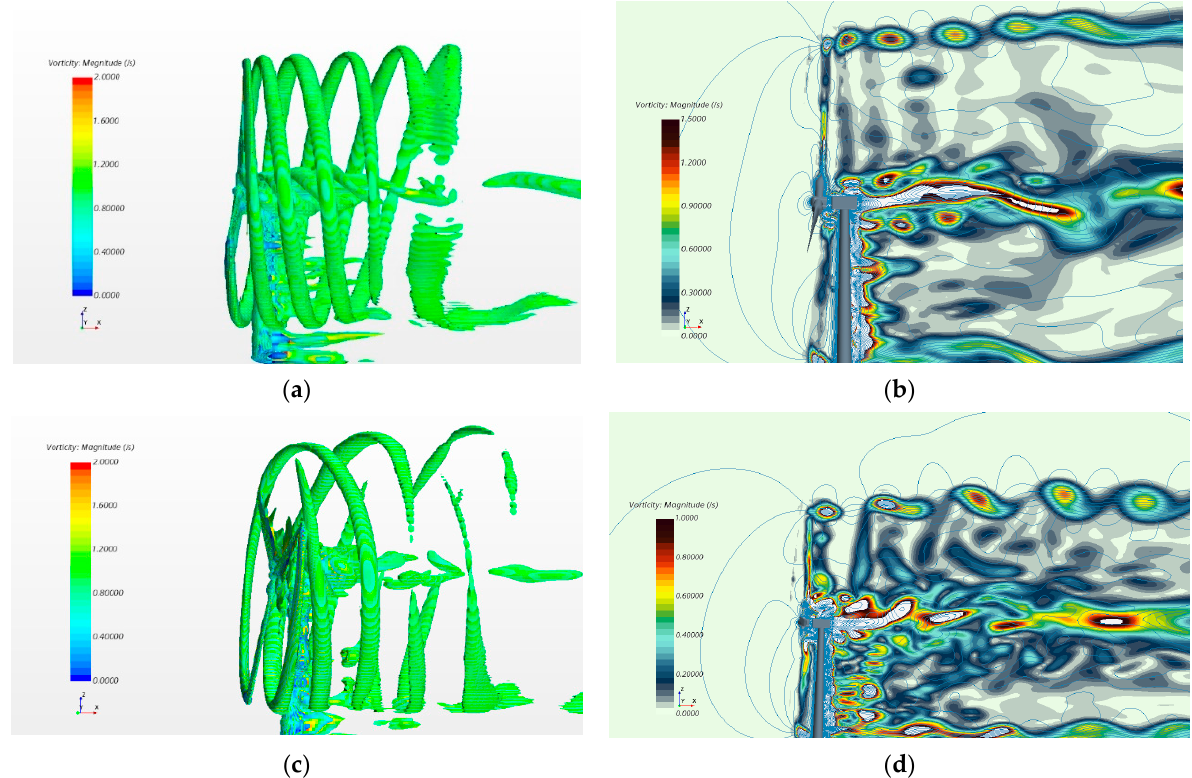
Figure 7. Wake scheme under pitch motion. ( a ) Iso-surface at T0 moment under case 3; ( b ) velocity in the symmetry plane at T0 moment under case 3; ( c ) iso-surface at T0 moment under case 5; ( d ) velocity in the symmetry plane at T0 moment under case 5.